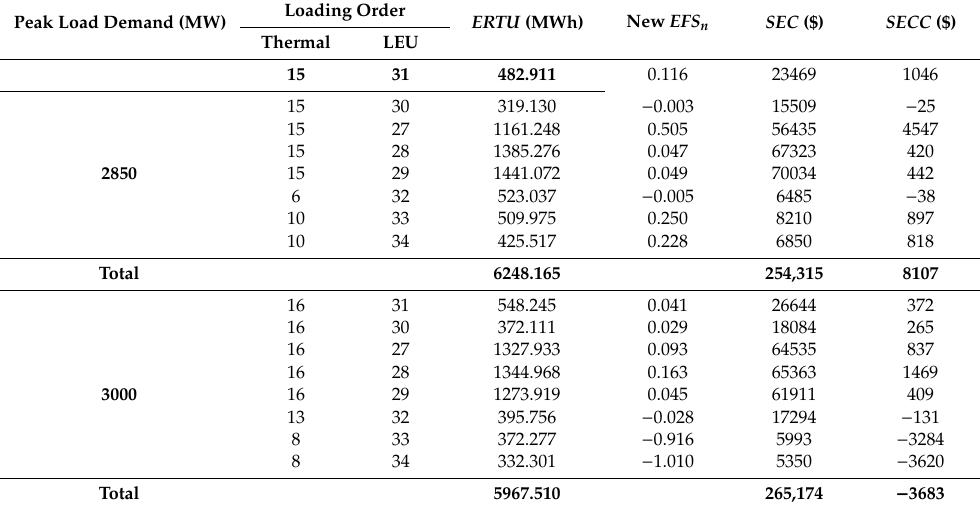
Table 5. Results of SUC estimated indirect by referring the objective function of ERTU based on MABC-NSM for the peak-load demand of 2850 and 3000